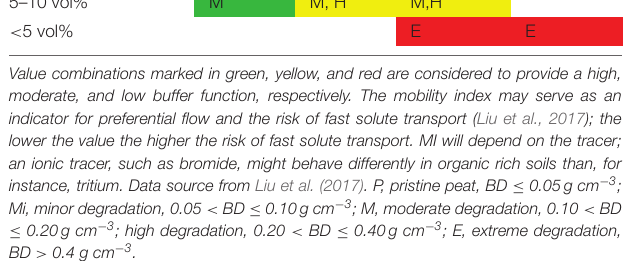
TABLE 2 | Classification scheme for the “filter and buffer function” of peat soils as based on the macro-porosity and mobility index (MI). MacroporosityMI > 1.2